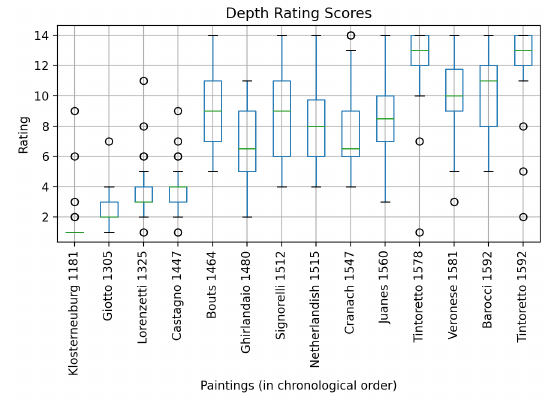
Figure 5. Depth rating of each painting in percentages—0% signifies the lowest amount of depth and 100%, the highest. The paintings are presented in chronological